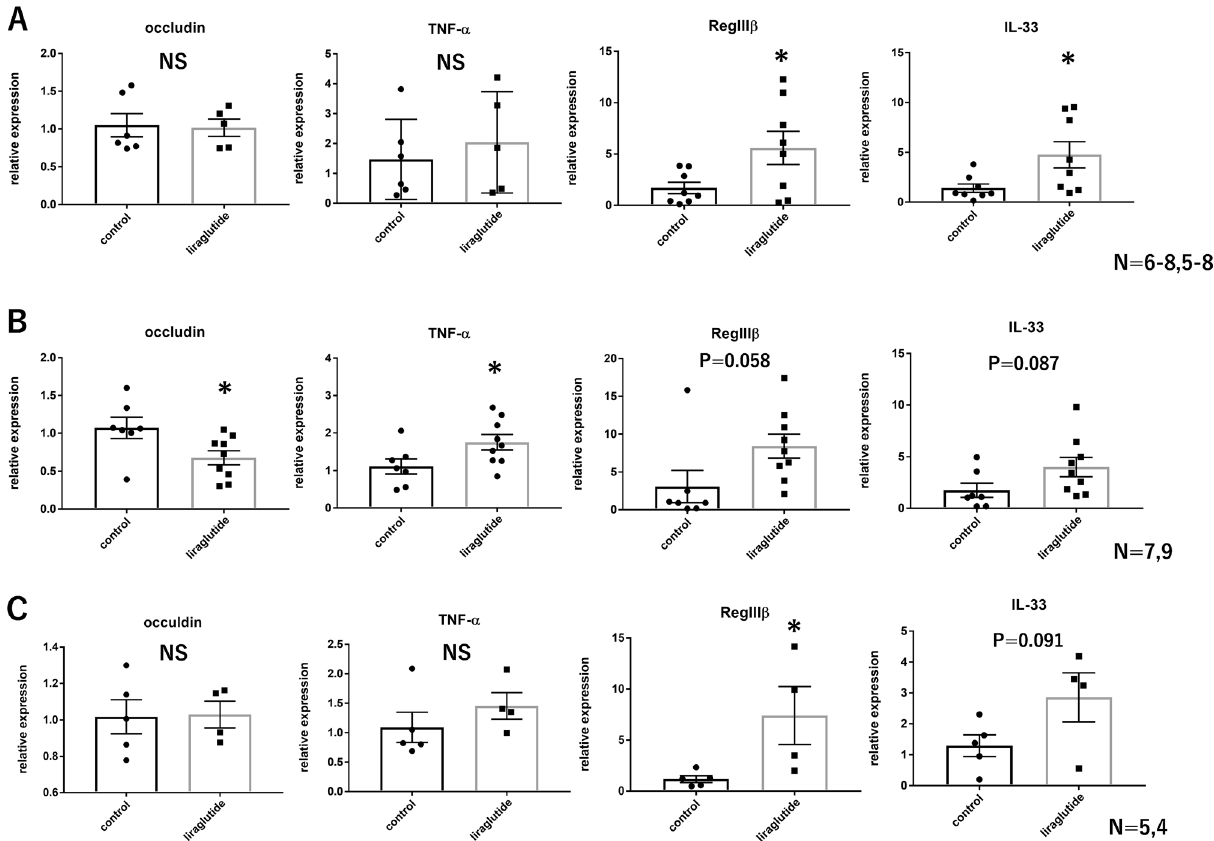
Figure 5. In DSS colitis, liraglutide attenuates tight junction gene expression in the cecum. Relative expression of cecal genes with or without acute liraglutide administration ( A ) in wild-type mice (control, n = 6–8; liraglutide, n = 5–8), ( B ) in wild-type mice (control, n = 7; liraglutide, n = 9), and ( C ) in TLR4KO mice with DSS colitis (control, n = 5; liraglutide, n = 4). All values represent the mean ± SEM. * P < 0.05, ** P < 0.01, *** P < 0.001; NS, not significant by non-paired t-test ( A – C ). All figures were drawn using GraphPad Prism 7 (www. graph pad. com) and Microsoft’s PowerPoint 2016 (www. micro soft.